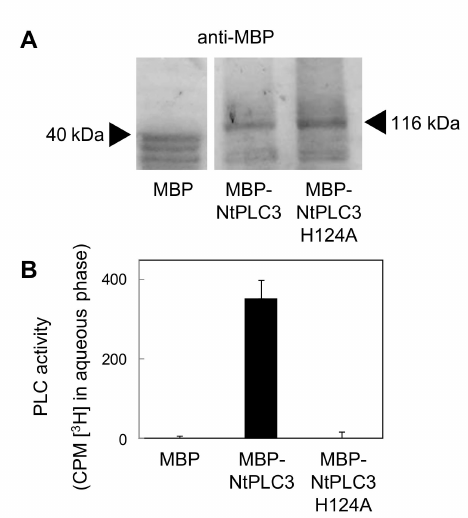
Figure 2. A catalytically inactive NtPLC3 variant, NtPLC3 H124A. A catalytically inactive variant of NtPLC3 to study dominant negative e ff ects in vivo was generated by substituting histidine 124 for alanine. The e ff ect of this substitution on enzyme function was tested using protein recombinantly produced in E. coli as a fusion to an N-terminal maltose-binding protein (MBP)-tag. ( A ) Immuno detection of recombinant MBP control, MBP-NtPLC3 and the dominant negative MBP-NtPLC3 H124A using an anti-MBP antibody, as indicated. ( B ) Catalytic activity of recombinant MBP, MBP-NtPLC3 and MBP-Nt-PLC3 H124A against a 2[ 3 H]PtdIns(4,5)P 2 substrate in vitro. Data are the mean ± SD